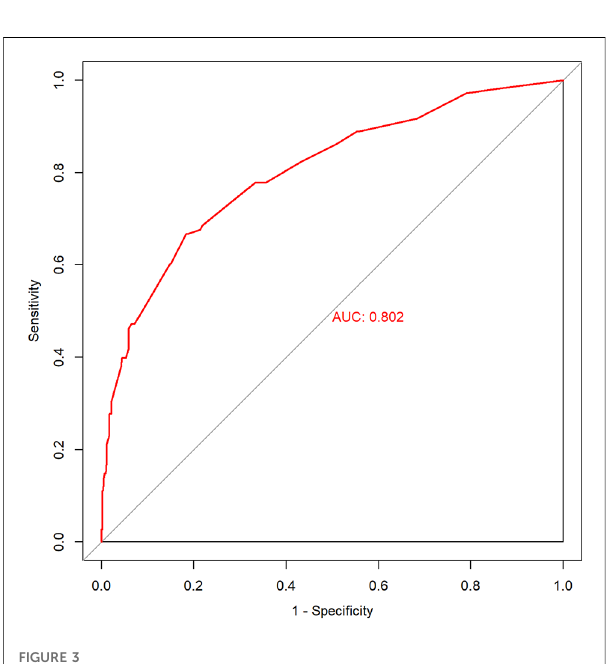
FIGURE 3 The ROC curve analysis of the nomogram.